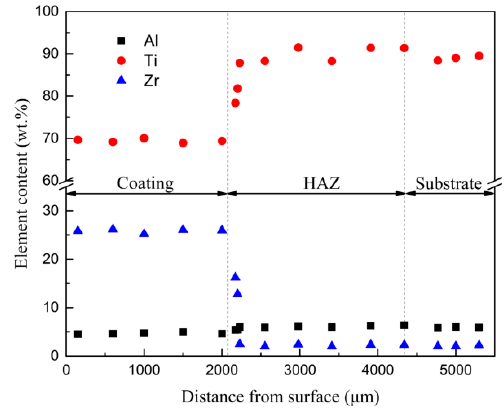
Figure 6. Elemental distribution at different distance away from surface (30ZrN).